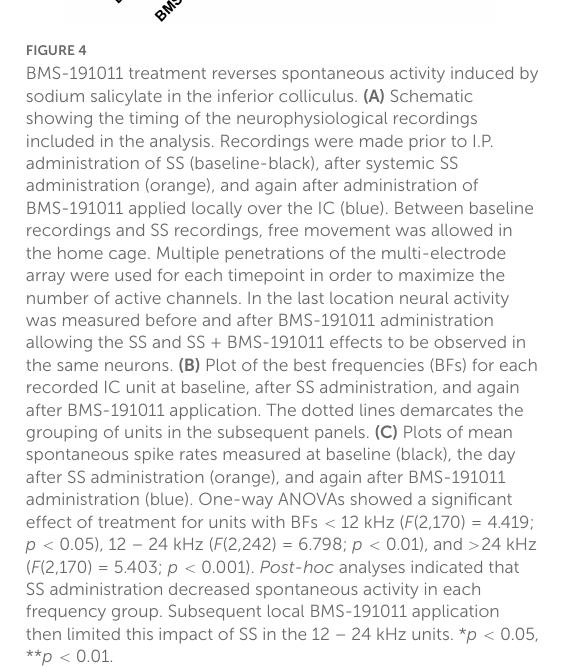
then limited this impact of SS in the 12 – 24 kHz units. * p < 0.05, ** p <